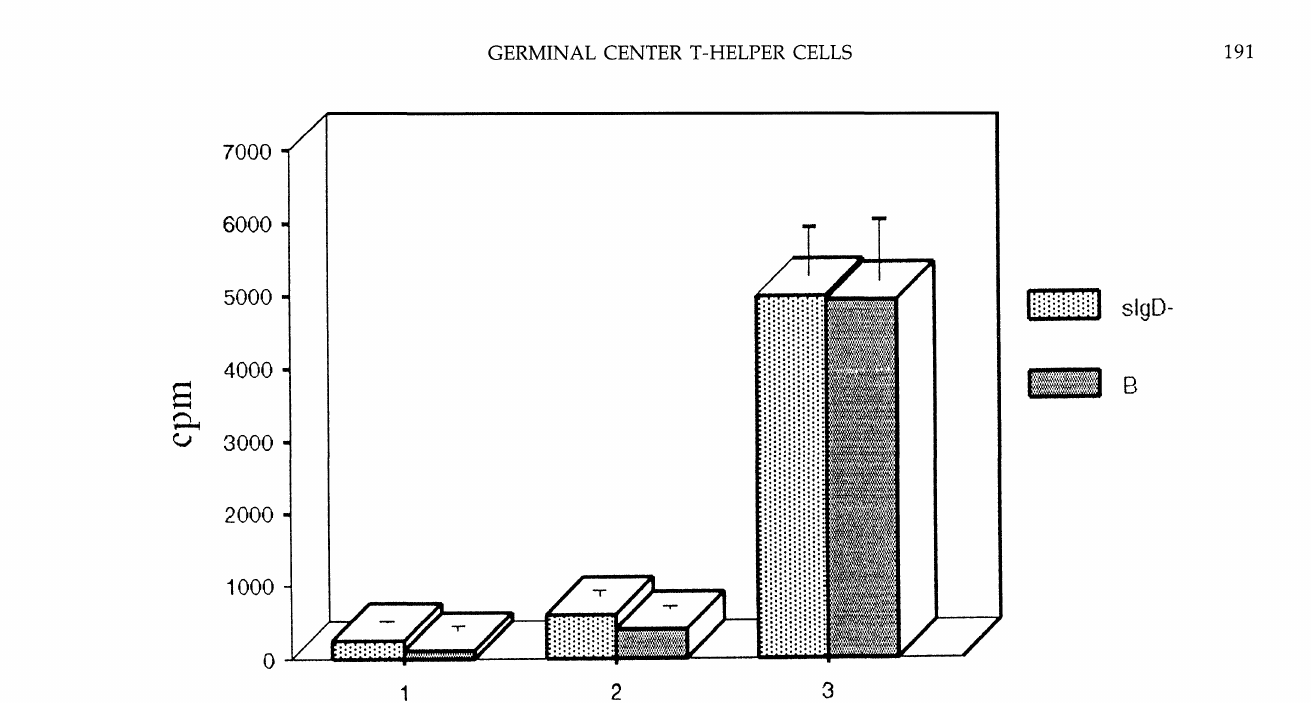
FIGURE 2. Proliferation of unsorted B cells or IgD-B cells in presence of CD57 or CD57- cells. B cells or sIgD-B cells (105 cell per well) were cocultured with mitomycin-C-treated CD57 or CD57- cells (3 x 105 g/well), sIgD- cells were sorted using anti-IgD- mAb and the MACS procedure. PHA was added whole during culture duration to maintain T-cell activation. B-cell proliferation was measured after 48 hours. The results are expressed as the mean of quadriplicate cultures. In 1: B cells and sIgD cells alone; 2: B cells and sIgD- cells and CD57 3: B cells and sIgD- cells and CD57-.